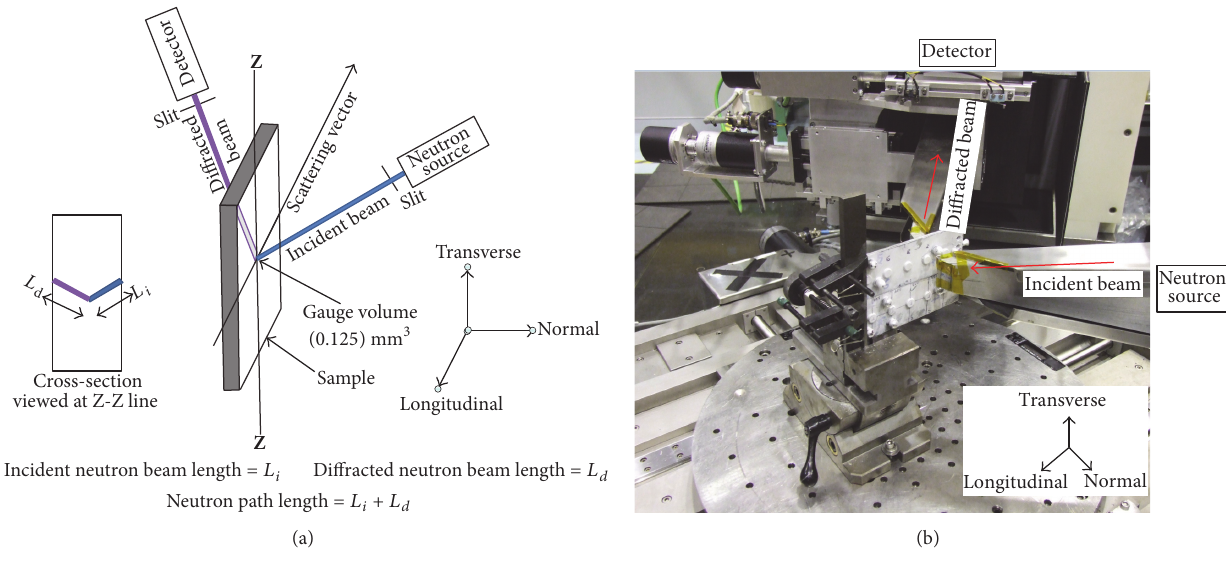
Figure 3: Strain measuring setup: (a) schematic and (b) experimental.